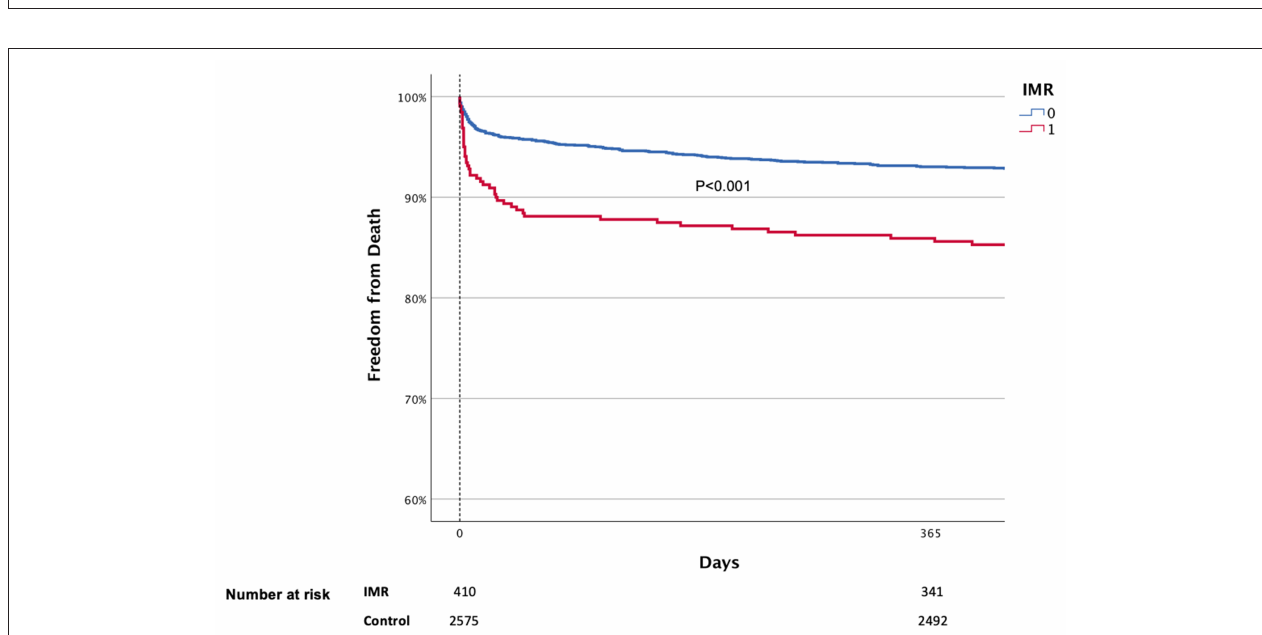
FIGURE 4 | Kaplan Meier curves of survival by IMR.